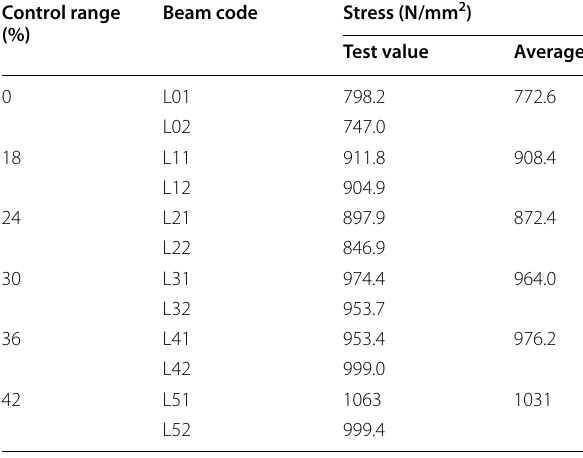
Table 5 Failure stress of steel